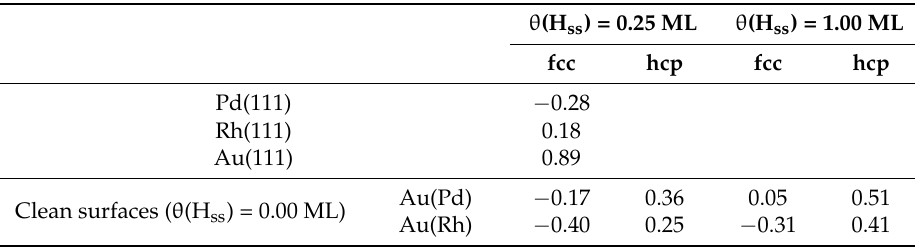
Table 4. Binding energy ∆ E bind of hydrogen absorbed on mono- and bimetallic surfaces, calculated according to Equation (2). The binding energy was only calculated for the absorbed hydrogen atoms, labeled as H ss . The labels Au(Rh) and Au(Pd) correspond to a Rh or Pd complete monolayer in the Au(111) slab, respectively. The energies are in eV.